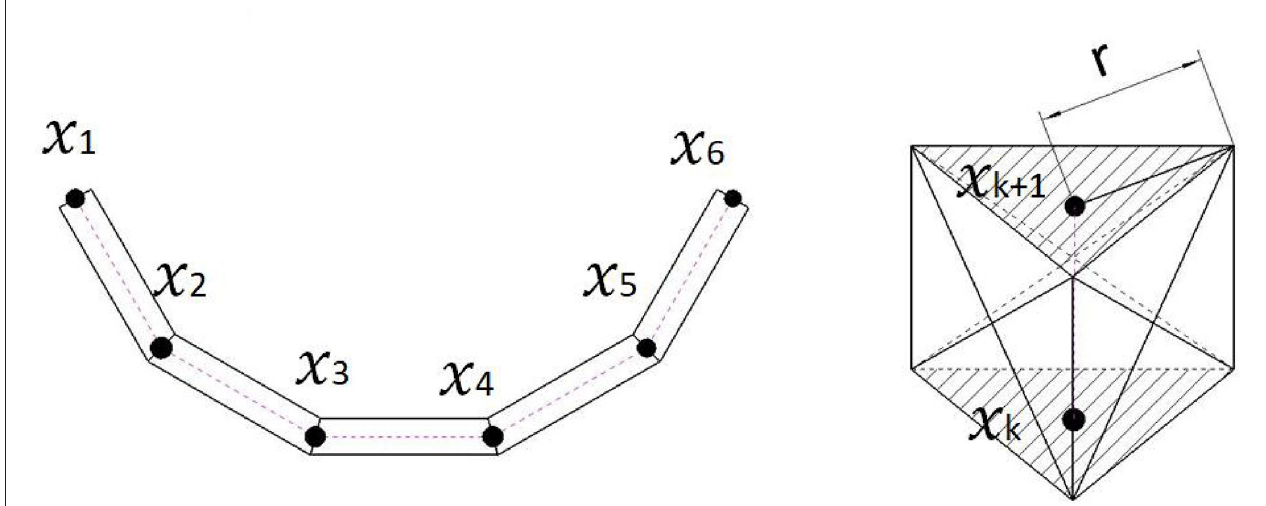
FIGURE 2 | The left figure is the demonstration of a deformable linear objects (DLOs) model with five elements. In the 3D case, these elements are pentahedrons, as is shown in the right figure. The size of the pentahedrons depends on the r and the distance between two neighbor registration points.